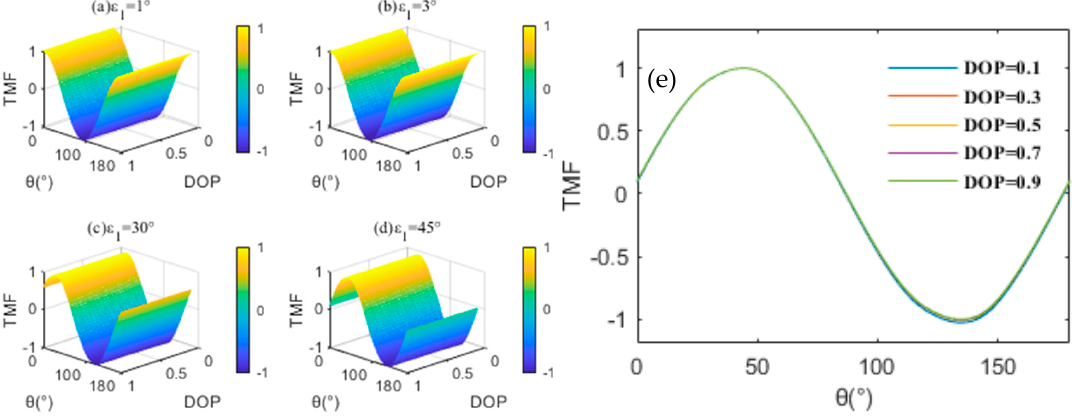
Figure 3. ( a – d ) Array of Z analytic values varying with the simulated illuminant. ( e ) Front view of array of Z analytic values at ε 1 = 45 .